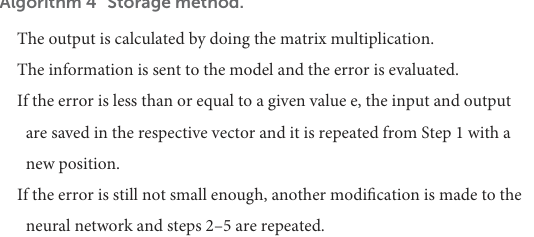
Algorithm 4 Storage